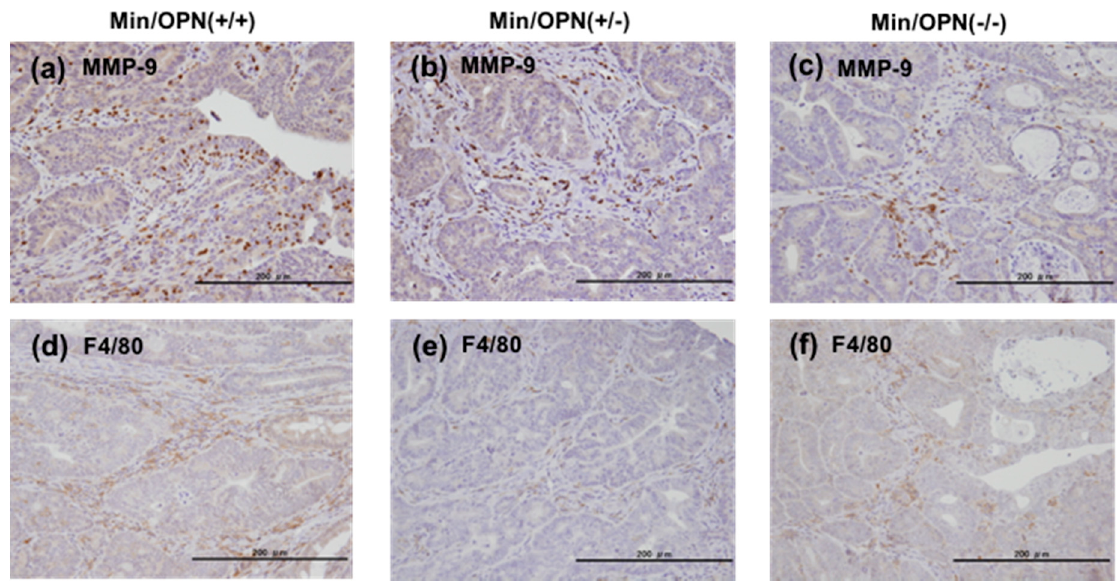
Figure 5. Protein expression in colorectal tumor tissue. ( a – c ) MMP-9 and ( d – f ) macrophage marker F4/80 were immunohistochemically stained in colorectal tumors in Min/OPN(+/+), Min/OPN(+/ − ), and Min/OPN( − / − ) mice, respectively. Objective magnification: ×40.